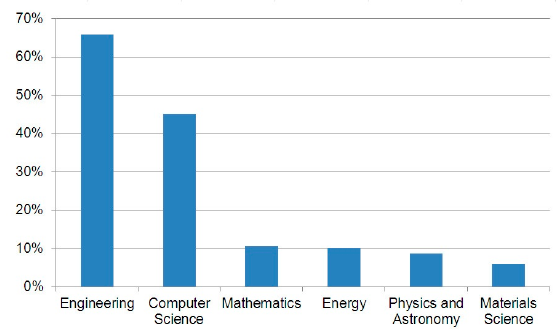
Figure 3. Number of publications per year from 1996 to 2017.